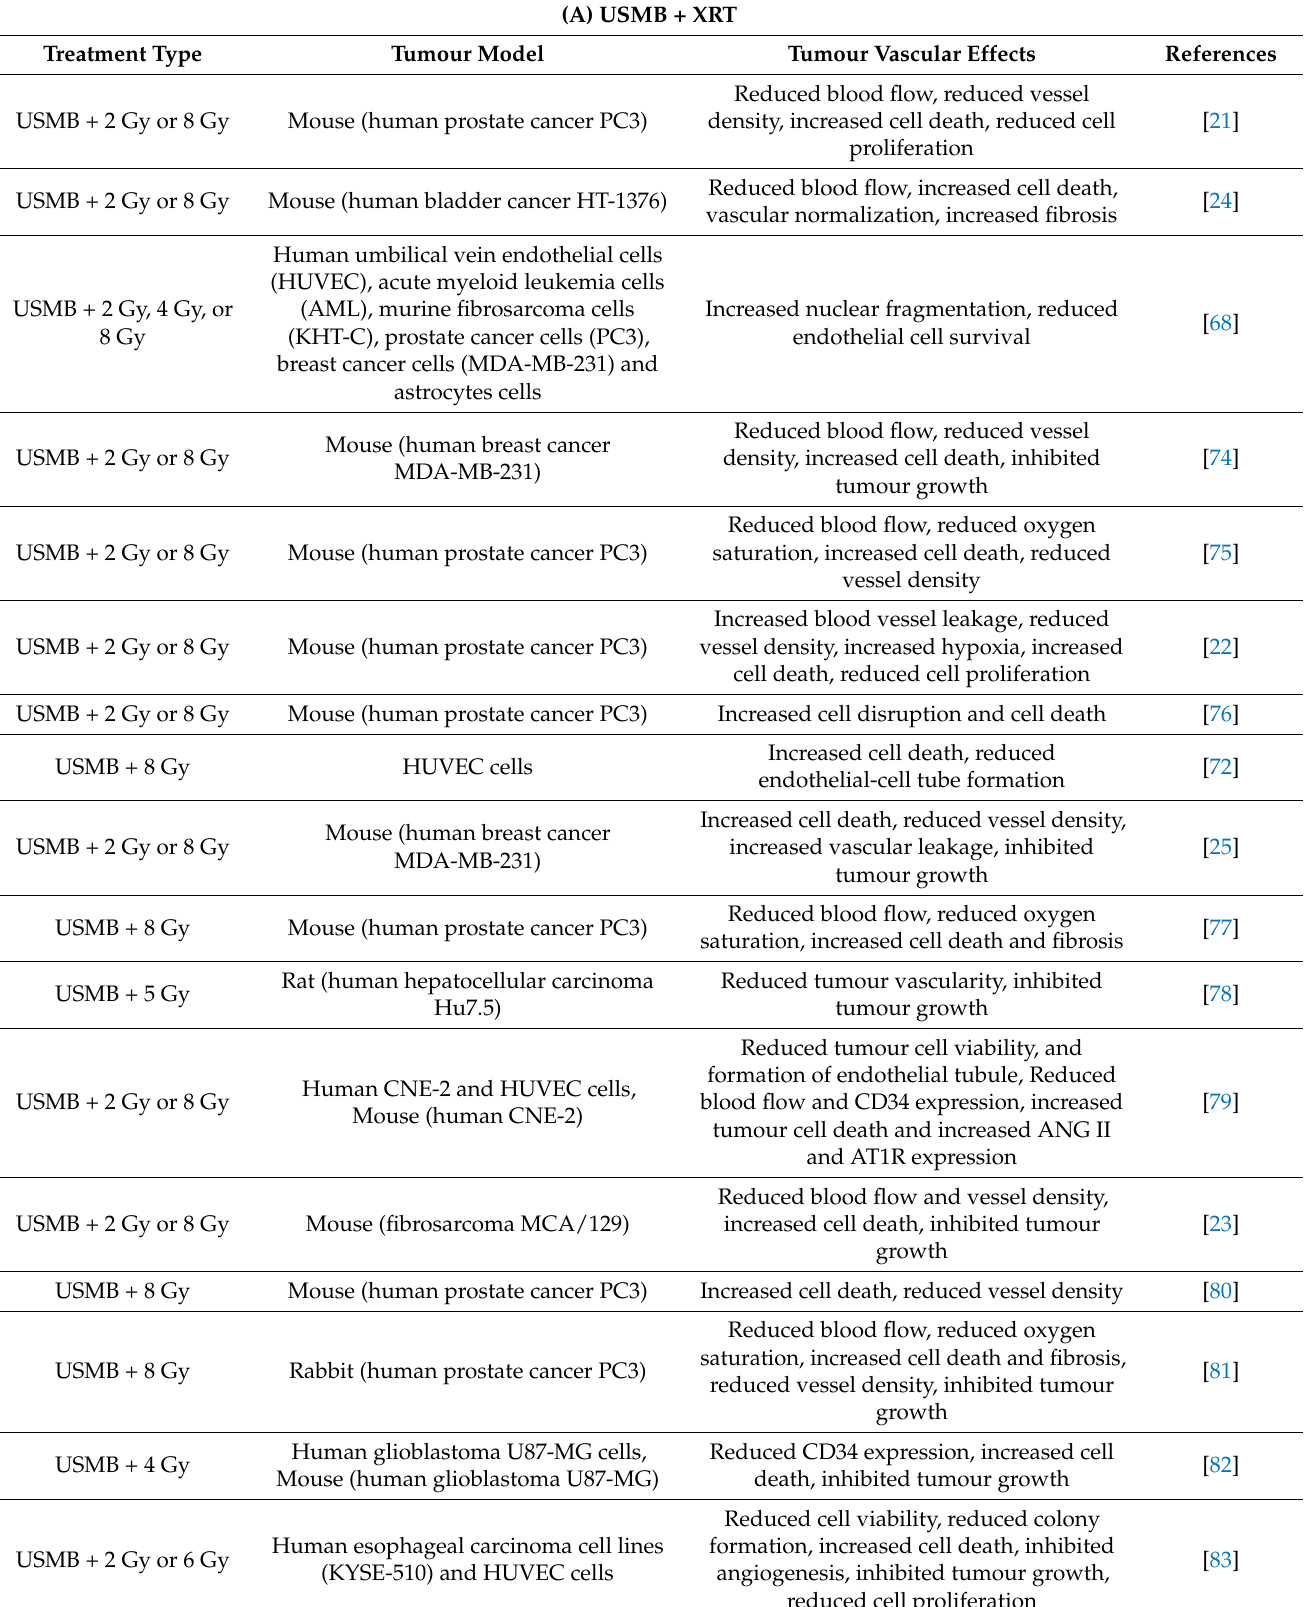
Table 1. USMB + XRT, chemotherapy-induced vascular effects observed in preclinical